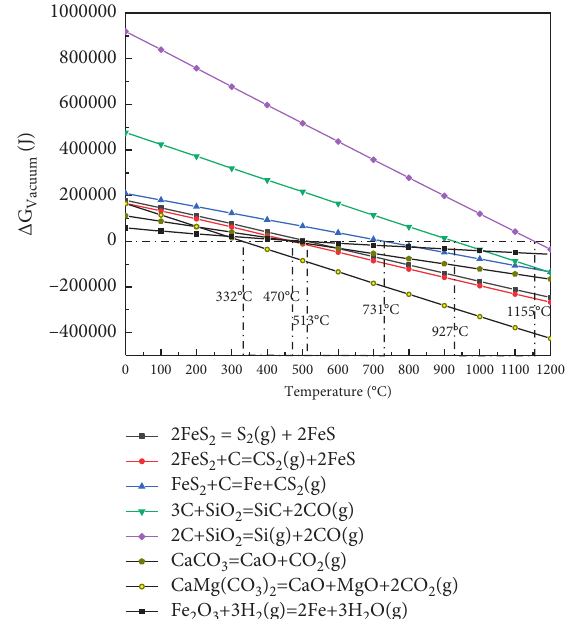
Figure 11: The results of thermodynamic analysis of main reactions in vacuum